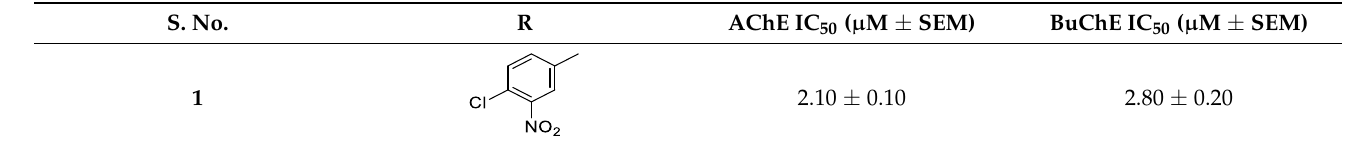
Table 1. Indole-based thiadiazole ( 1–16 ) derivatives and their acetylcholinesterase and butyryl- cholinesterase inhibition profile. S.